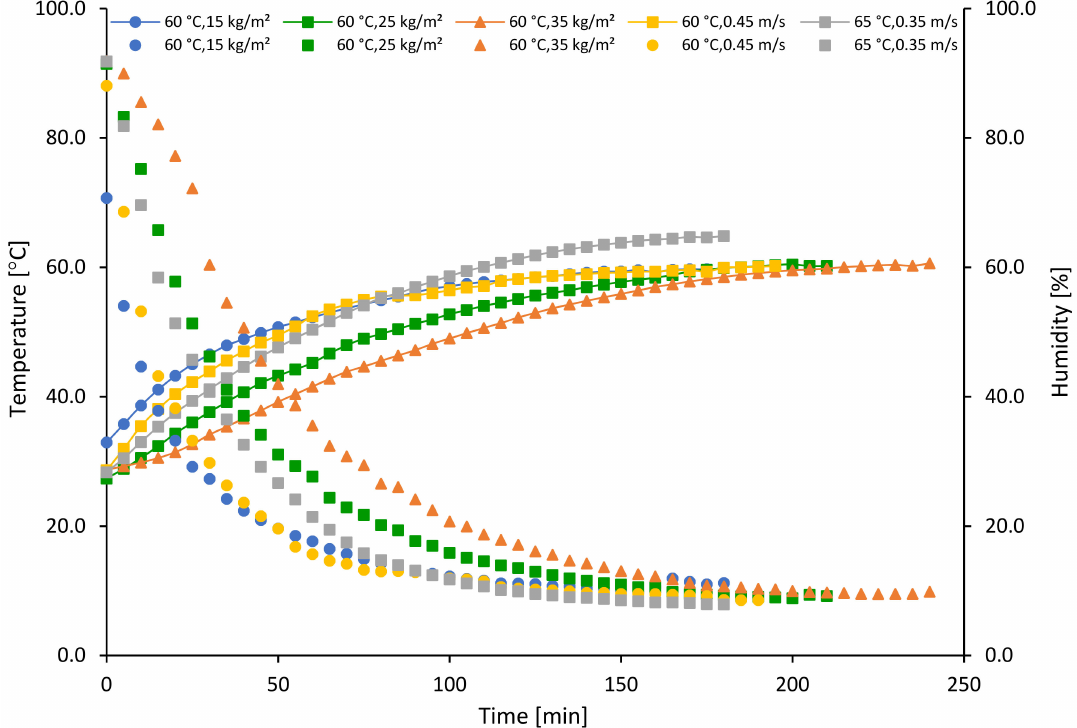
Figure 4. Temperature (symbol and line) and humidity (symbol) profile for di ff erent bulk weight and di ff erent process